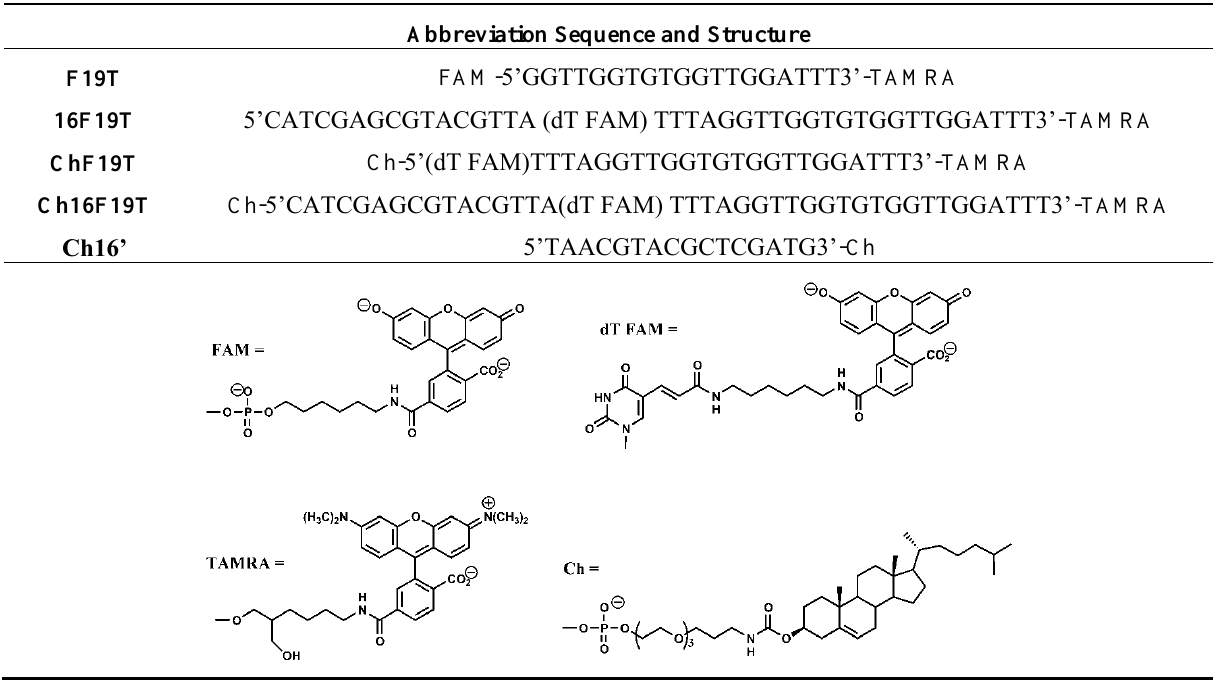
Table 1. Oligonucleotide probes used in this